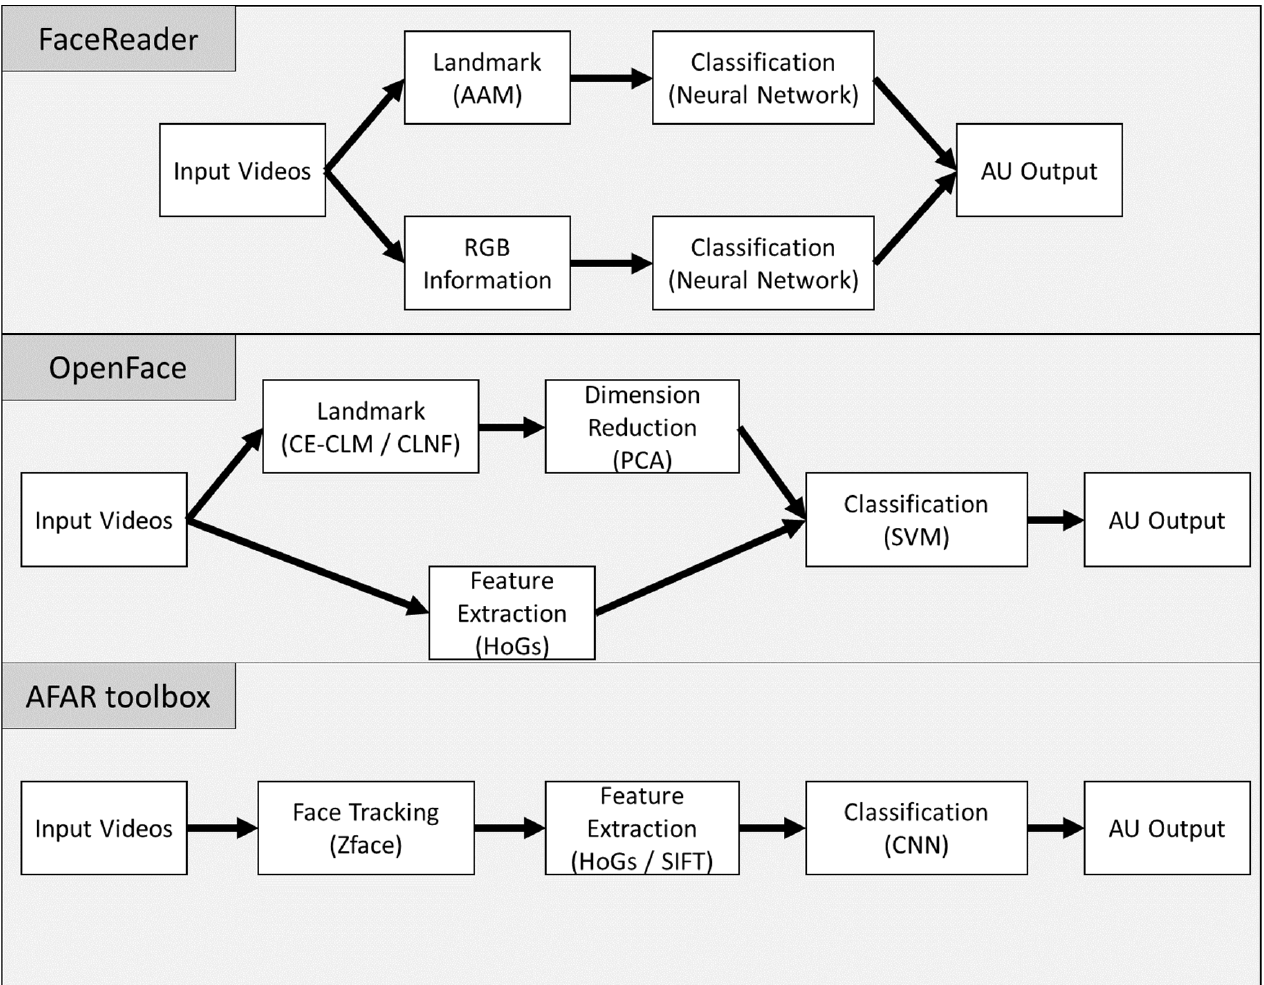
Figure 1. Pipelines of FaceReader, OpenFace, and the AFAR toolbox.